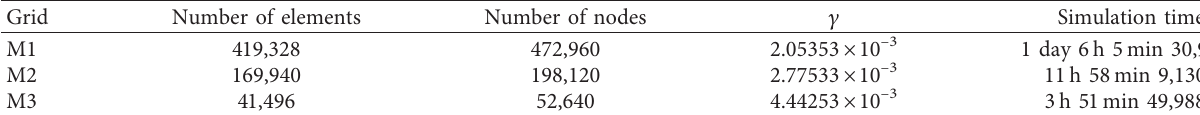
Table 5: Quantitative data of the numerical grids evaluated.